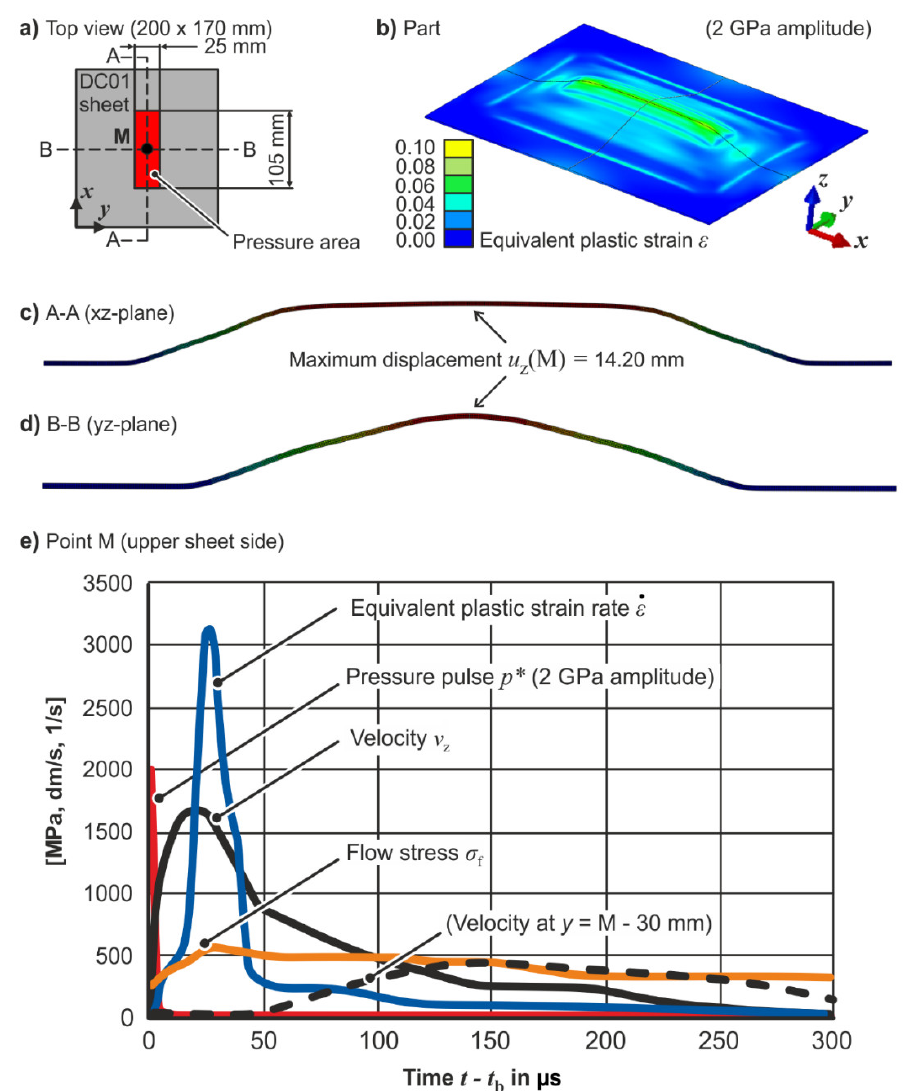
Figure 4. Numerical results for pressure distribution PD1: ( a ) sketch, ( b ) formed part, ( c – d ) sectional views at process end, ( e ) selected node-/integration point treatment.